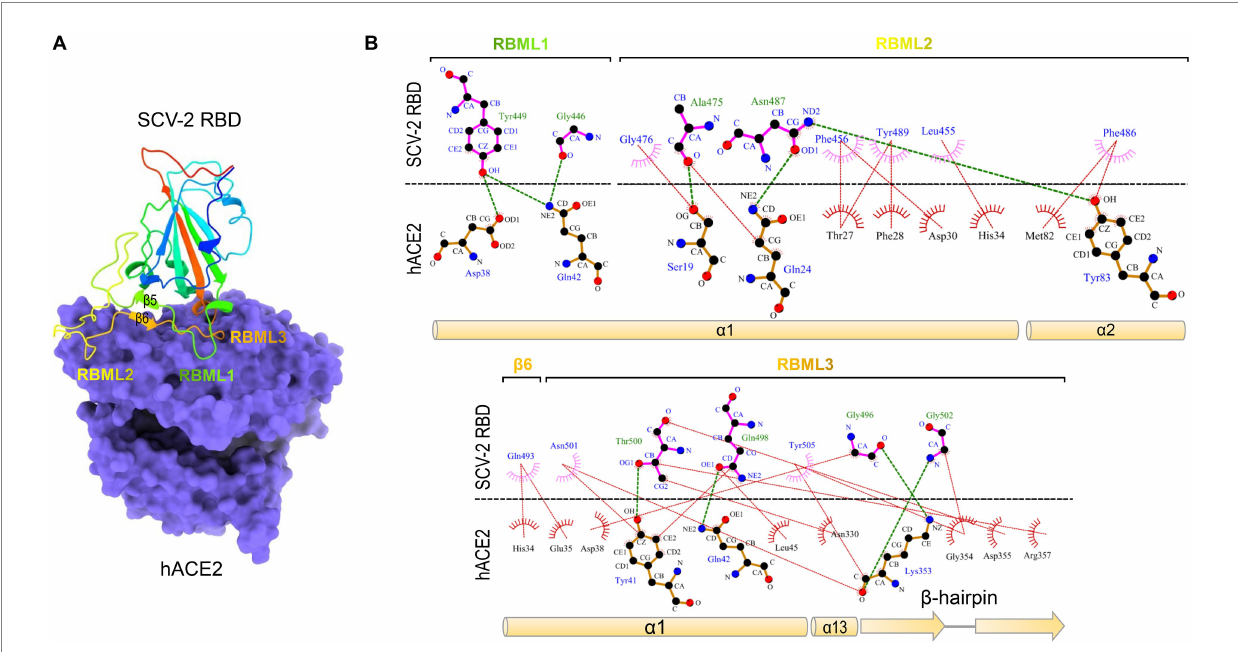
FIGURE 1 The SARS-CoV-2 RBD binds to hACE2 via residues located on the three loops. (A) The structure of SARS-CoV-2 RBD and hACE2 complex. The RBM comprising the three loops (designated as RBML1 to RBML3) docks onto the surface of hACE2 (shown in purple; pdb entry 6LZG). (B) LigPlot+ plot of the interaction diagram. Hydrophobic contacts and hydrogen bonding between the two loops (RBML1 and RBML2) of the RBD and the two α -helices ( α 1 and α 2) of hACE2 are shown at the top and the interactions between RBML3 and α 1, α 13, and the β -hairpin of hACE2 at the bottom. The horizontal dotted line represents the interface, in which the residues involved in direct intermolecular hydrophobic contacts are shown as semicircles with radiating spoke and linked by red dotted lines and hydrogens (<4 Å) are represented by green dashed